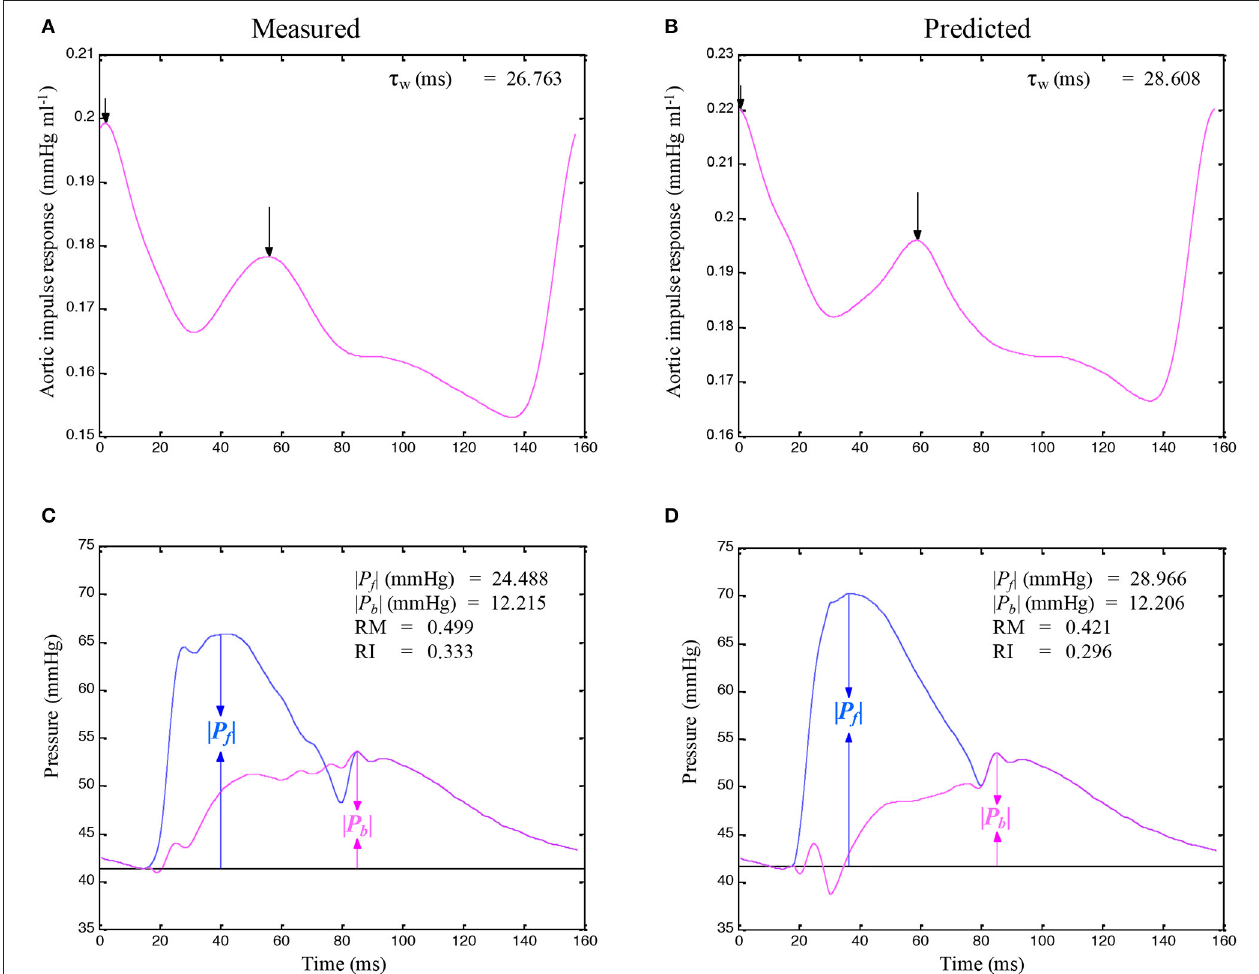
FIGURE 2 | Similarity between the measured aortic impulse response obtained from the measured pressure and Q m (A) and the predicted aortic impulse response obtained from the measured pressure and Q tri (B) in the same rat, which is shown in Figure 1 . The measured P f and P b waves (C) and the predicted P f and P b waves (D) are also depicted. In ( C,D ), the amplitudes (peak - trough) of the P f and P b are represented by | P b | and | P f | , respectively. P f , forward pressure wave; P b , backward pressure wave; RM, wave reflection magnitude, given by | P b | / | P f | ; RI, wave reflection index, given by | P b | /( | P f | + | P b | ); Q m , measured aortic flow; Q tri , uncalibrated triangular flow; τ w , wave transit